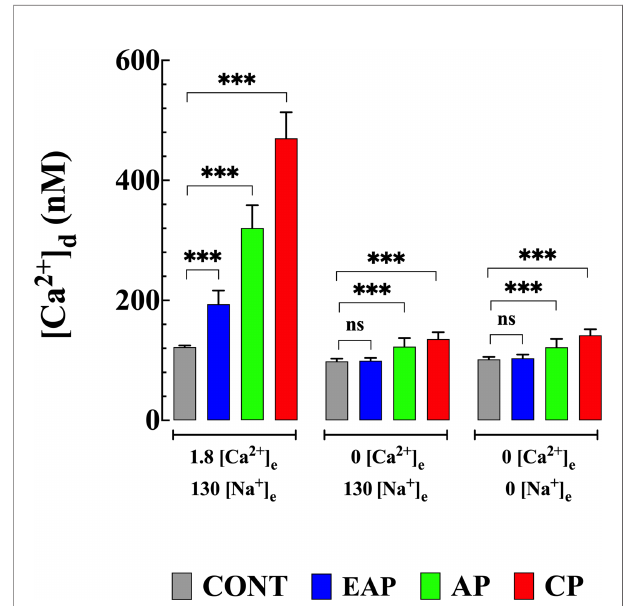
FIGURE 4 | Effect extracellular Ca 2+ on Na + depletion-induced elevation of [Ca 2+ ] d . [Ca 2+ ] d was measured in cardiomyocytes from CONT, EAP-, AP-, and CP-infected mice in normal Tyrode, Ca 2+ -free Tyrode solution, and Ca 2+ and Na + free Tyrode solution. [Ca 2+ ] d was determined in quiescent cardiomyocytes from CONT ( n cells =16-24 and n mice =4), EAP-infect mice ( n cells =15-19 and n mice =5), AP-infect mice ( n cells =18-21 and n mice =6) and CP- infect mice ( n cells =15-18 and n mice =8). Data are expressed as mean ± S.E. Statistical analysis was performed as described above, *** p < 0.001. CONT, control mice; EAP, early acute phase of infected mice; AP, acute phase of infected mice; and CP, chronic phase of infected mice. ns, no signi fi